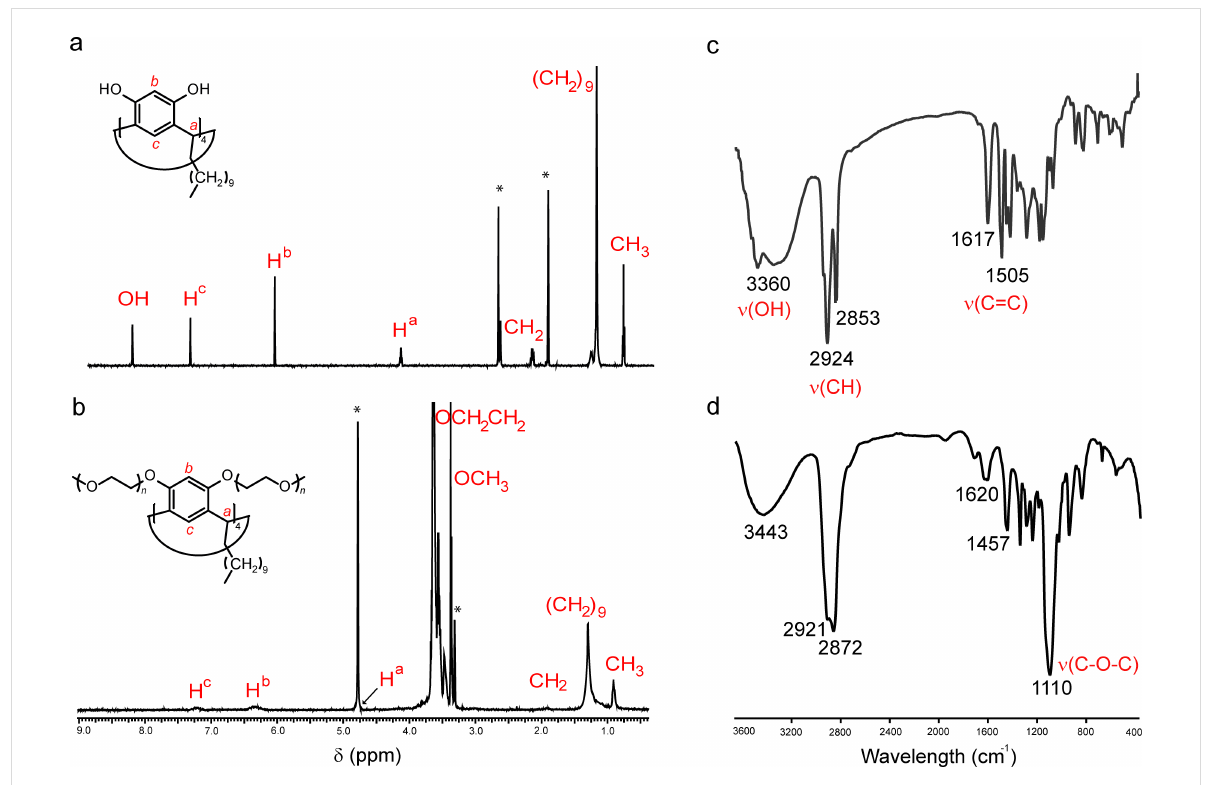
Figure 1: (a, b) 1 H NMR spectra of (a) macrocycle 1 in acetone- d 6 and (b) macrocycle 3 in CD 3 OD; (c, d) FTIR spectra of (c) 1 and (d) 3 .